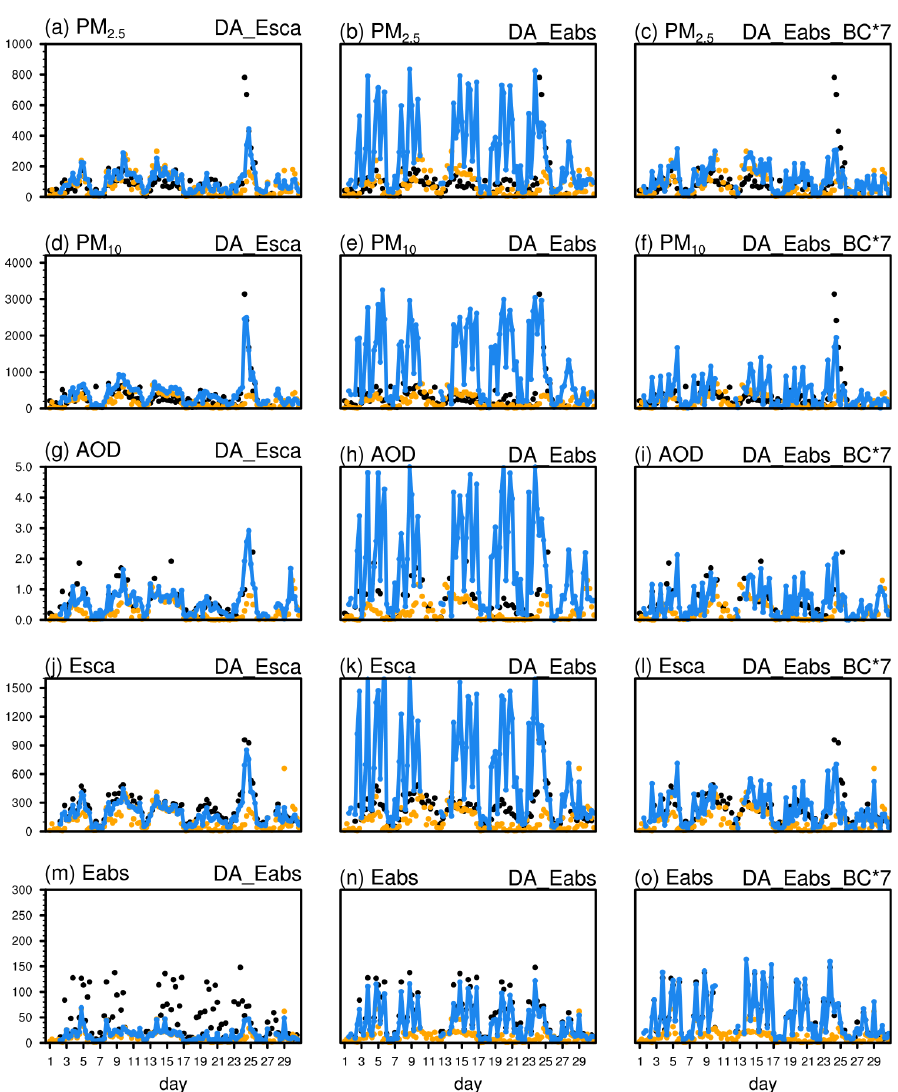
Figure 7. Comparison of PM 2 . 5 (µgm − 3 ; a – c ), PM 10 (µgm − 3 ; d – f ), 870nm AOD (g–i) , 635nm aerosol scattering coefficient (Esca, Mm − 1 ; j – l ), and 660nm aerosol absorption coefficient (Eabs, Mm − 1 ; m – o ) in the observation (black solid points), the background simulation (orange solid points), and the DA analyses (blue line) when assimilating the aerosol scattering coefficient (DA_Esca), aerosol absorption coefficient (DA_Eabs), and absorption coefficient with the background error of BC enlarged by a factor of 7 (DA_Eabs_BC*7) at Kashi in April